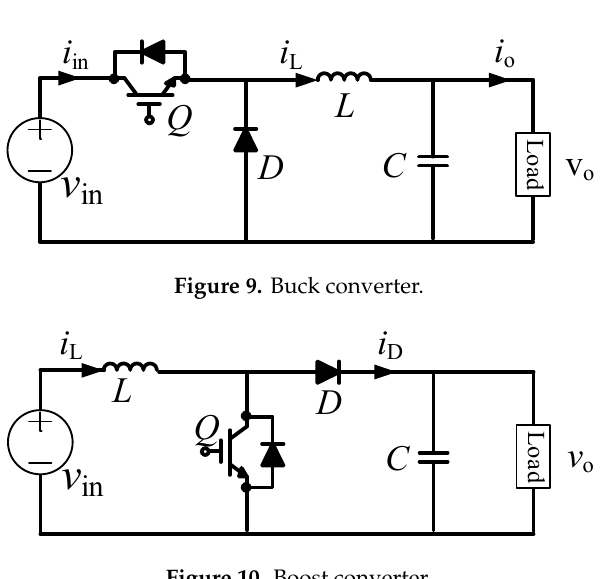
Figure 10. Boost converter.